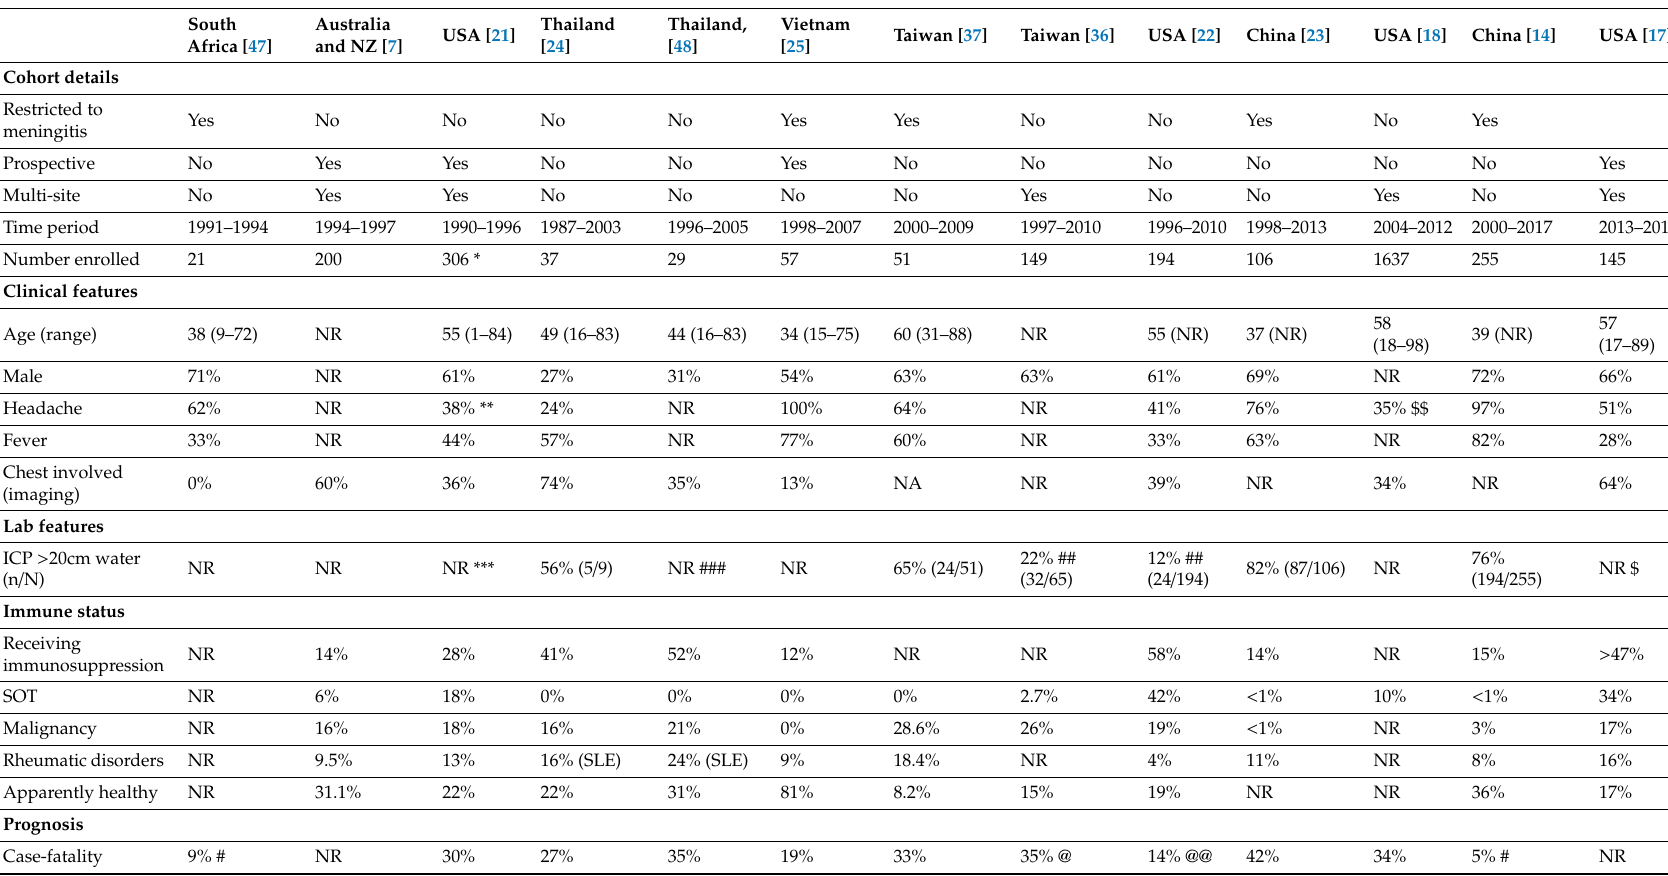
Table 2. Summary of main findings of patient details, clinical features, and clinical outcomes from cohorts of cryptococcosis including central nervous system infection in HIV-negative individuals cohorts (n > 20